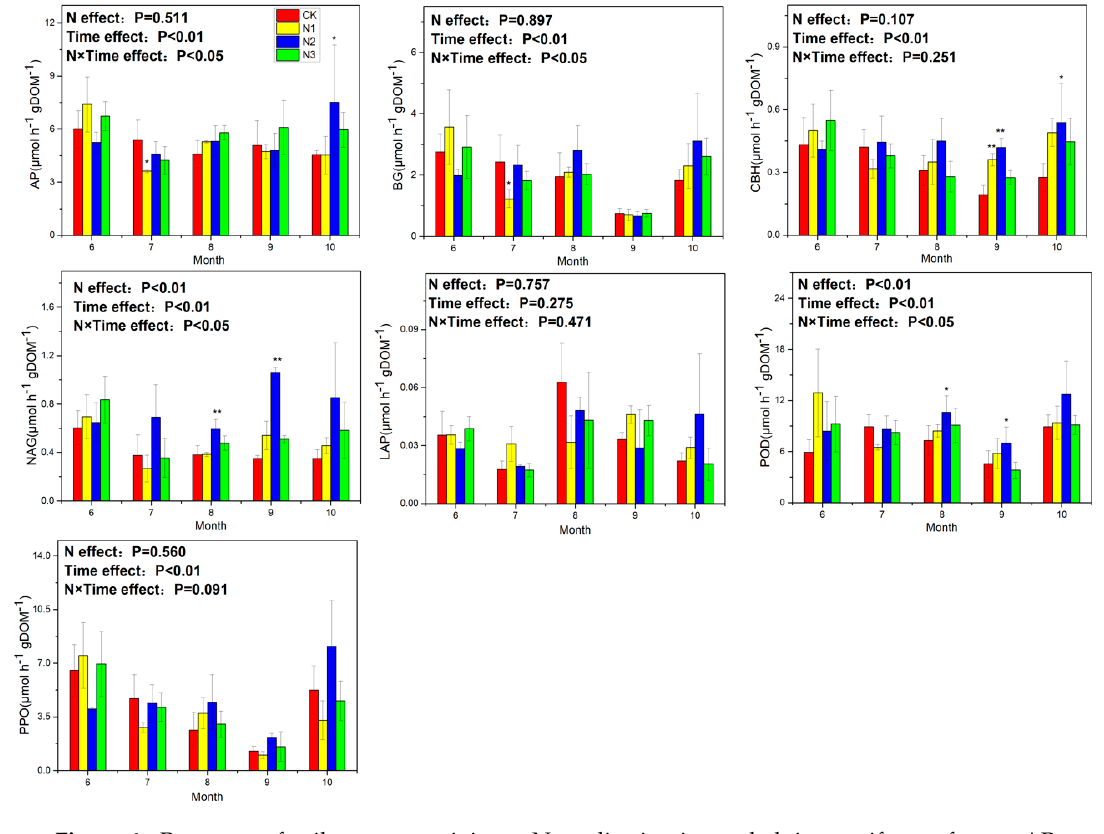
Figure 4. Response of soil enzyme activity to N application in a subalpine coniferous forest. AP, acid phosphatase; BG, β -glucosidase; CBH, cellobiohydrolase; NAG, β -N-acetylglucosaminidase; LAP, leucine aminopeptidase; PPO, polyphenol oxidase; POD, peroxidase. * indicates significant difference between N treatment and control ( p < 0.05), ** indicates extremely significant difference between N treatment and control ( p < 0.01) (repeated measures ANOVA, LSD multiple comparison).